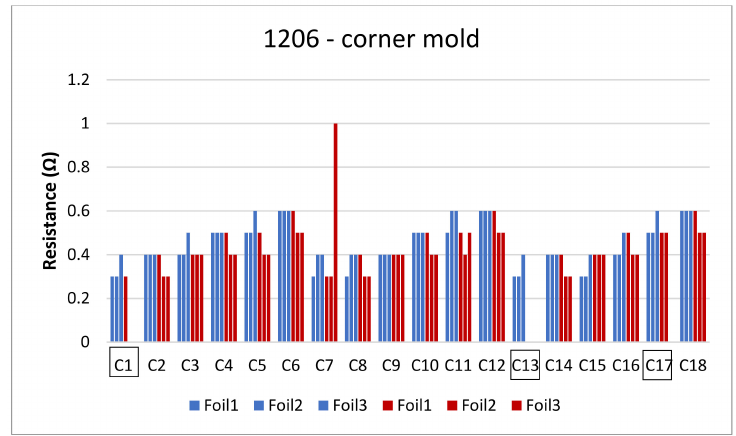
Figure 22. Resistance measurements for 1206 resistors molded in corner mold.